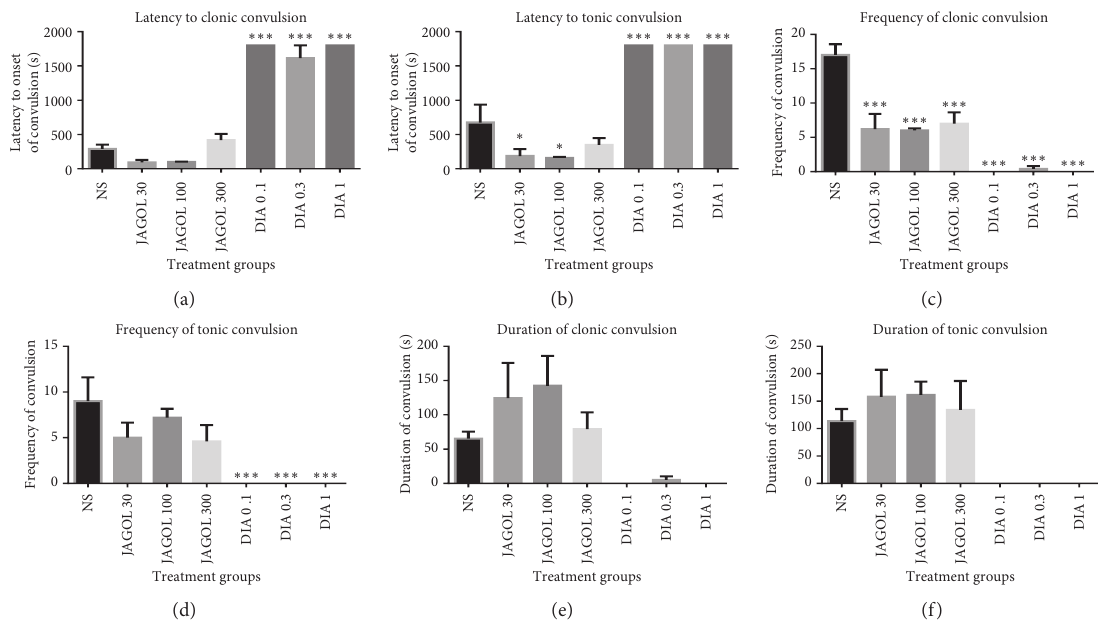
Figure 3: Effect of JAGOF (30–300 mg/kg, p.o .) and diazepam (0.1–1.0mg/kg, i.p .) on the latency to PTX-induced (a) myoclonic and (b) tonic convulsions, frequency of (c) myoclonic and (d) tonic convulsions, and duration of (e) myoclonic and (f) tonic convulsions. Each column represents the mean ± SEM ( n � 5). ∗∗∗ P < 0 . 001 and ∗ P < 0 . 05, one-way ANOVA followed by Bonferroni’s multiple comparison test. JAGOF: Jatropha gossypifolia fruit extract; DIA: